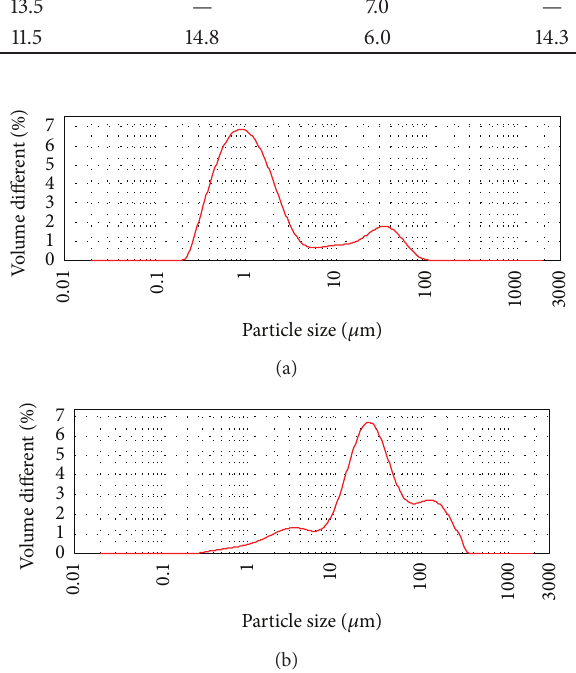
Figure 4: Laser particle size distribution of wax emulsion (a) and Ewax